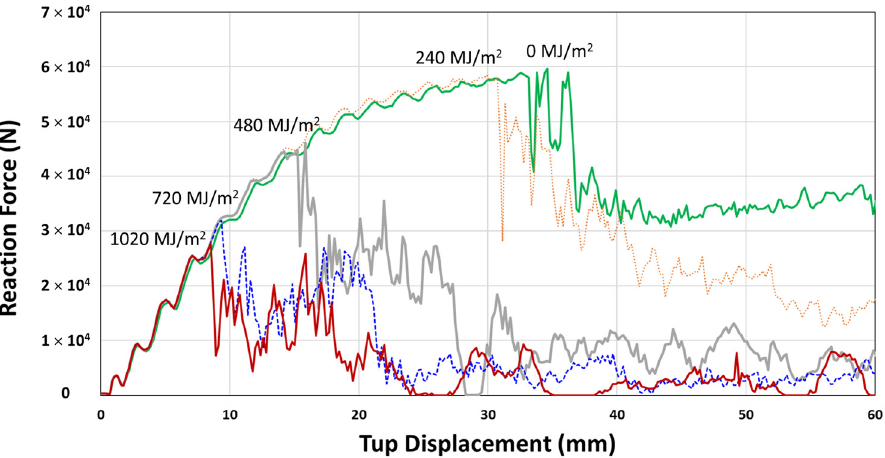
Figure 20. Reaction force versus tup displacement curves of 3-point bending impact analysis for weather-exposed PC channel section.